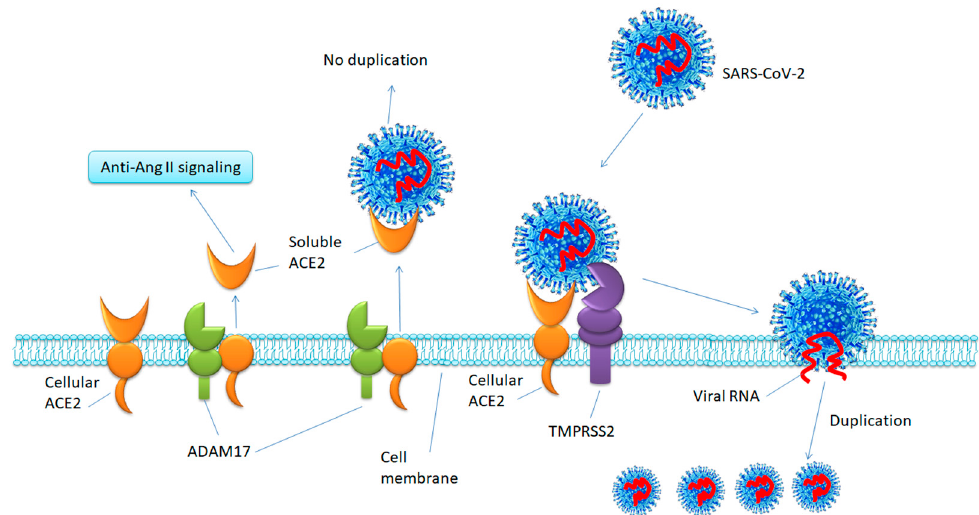
Figure 1. Hypothesis of ACE2 shedding and SARS-CoV-2 entry.